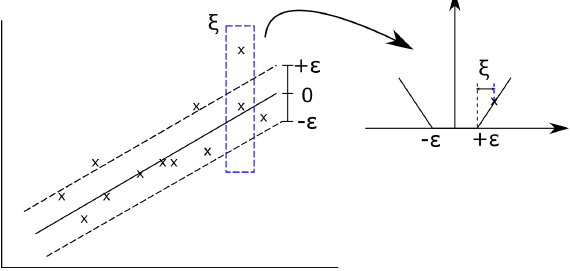
Figure 5. The soft margin loss setting for a linear SVM.